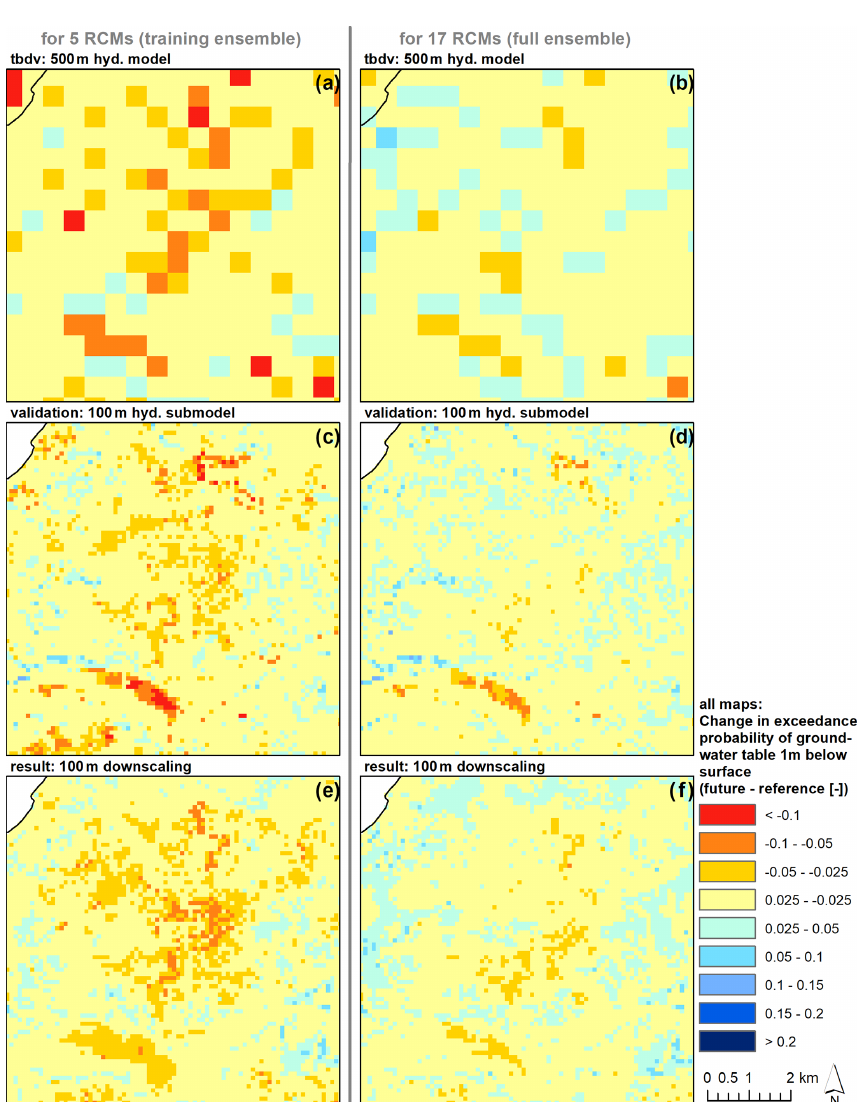
Figure 6. Downscaling outputs for validation submodel VI, for the example of ex1m nf . Left column: The RF downscaling was trained to downscale the median change of the five RCMs from the 500m HM (a) with the 100m HM training data ( c ; however, submodel VI is not included in the training). Downscaling results are shown in (e) . If applied for the full RCM ensemble (b, d, f) , the downscaling results (f) also align with the truth (d)